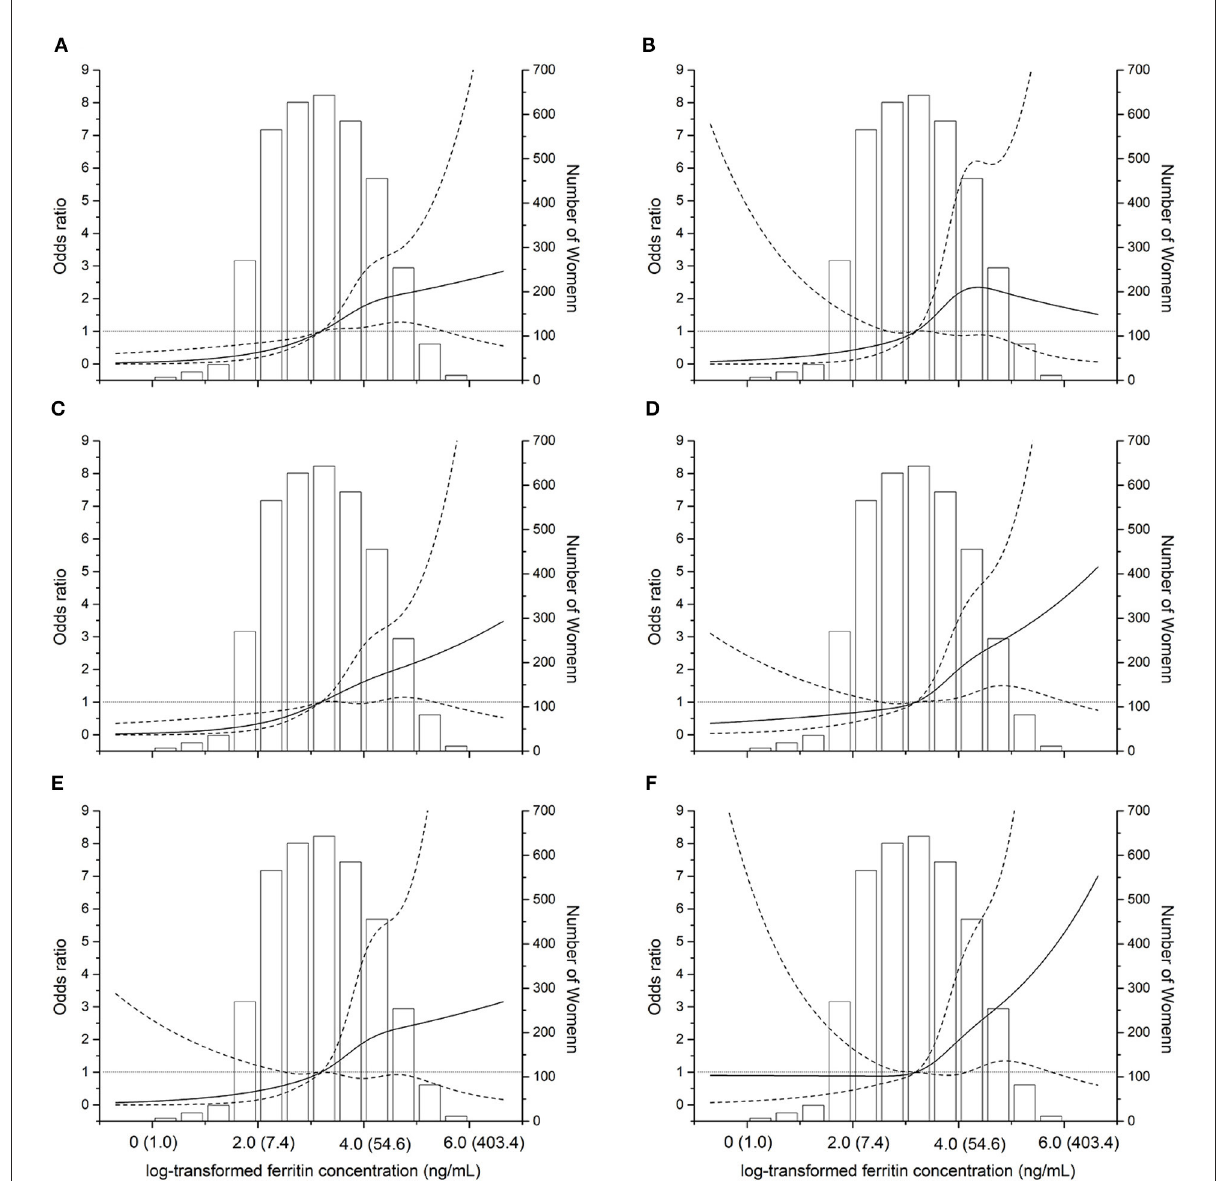
FIGURE2 Dose–response relationships between maternal ferritin concentrations and the risk of adverse birth outcomes. The restricted cubic spline for the association between serum ferritin and incident of LBW (A) . LBW (term) (B) . LBW (preterm) (C) . SGA (D) . Severe SGA (E) . Mild SGA (F) . The solid lines represent odds ratios (ORs) based on restricted cubic splines for the log-transformed levels of maternal ferritin, the dotted lines represent the confidence interval. The bars represent histograms of maternal ferritin concentration distribution among the total population. The numbers in parentheses show the maternal concentrations before log-transformation. The horizontal gray line represents OR = 1.